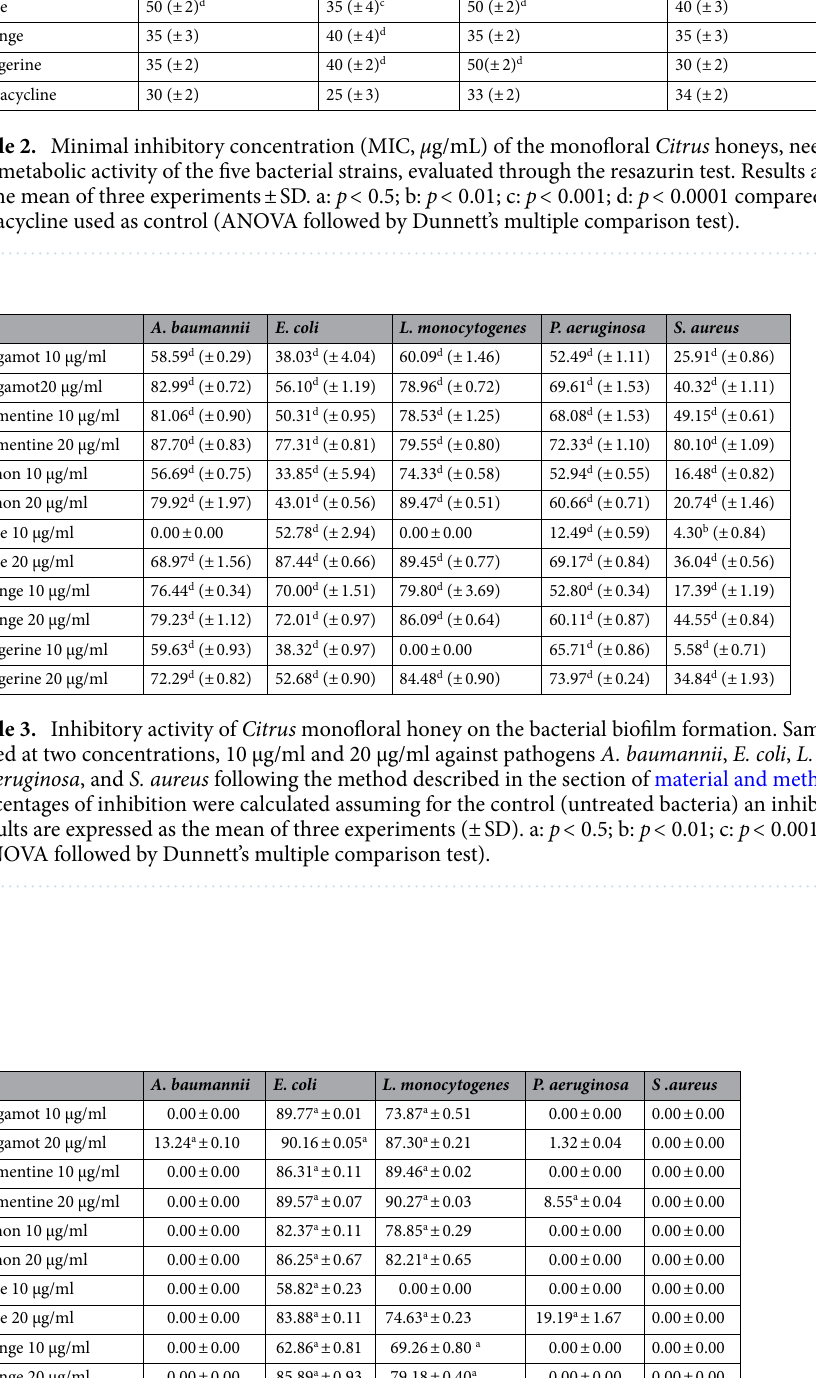
Table 4. Inhibitory activity of Citrus honey on the bacterial cell metabolism within biofilm, tested at concentrations of 10 µg /ml and 20 µg /ml. The percentage of inhibition was calculated assuming for the control (untreated bacteria) an inhibition = 0. Results are expressed as the mean of three experiments (± SD). a: p < 0.0001 (ANOVA followed by Dunnett’s multiple comparison test).